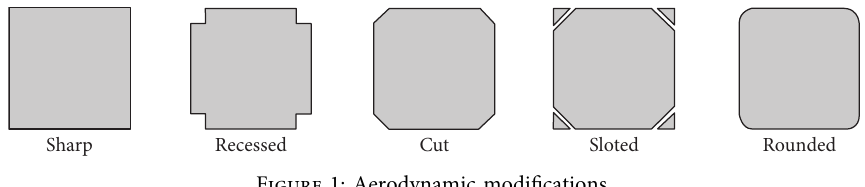
Figure 1: Aerodynamic modifications.